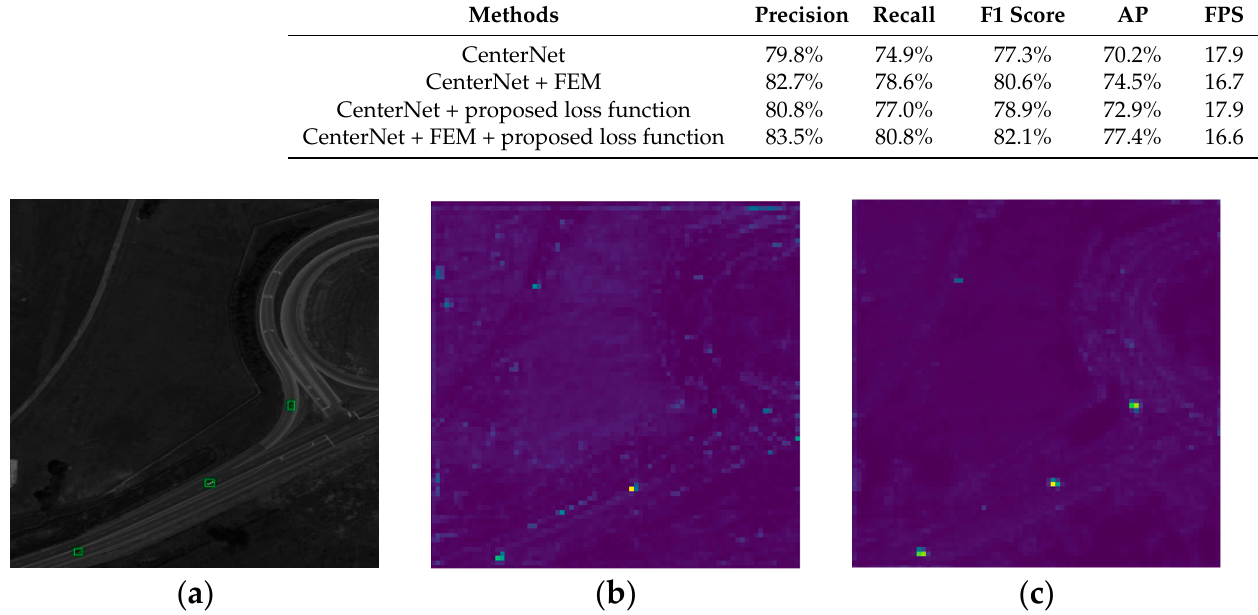
Figure 7. ( a ) Ground truth, ( b ) before enhancement, and ( c ) after enhancement. Visualization results of the FEM. Table 1. Ablation experiments for proposed method.